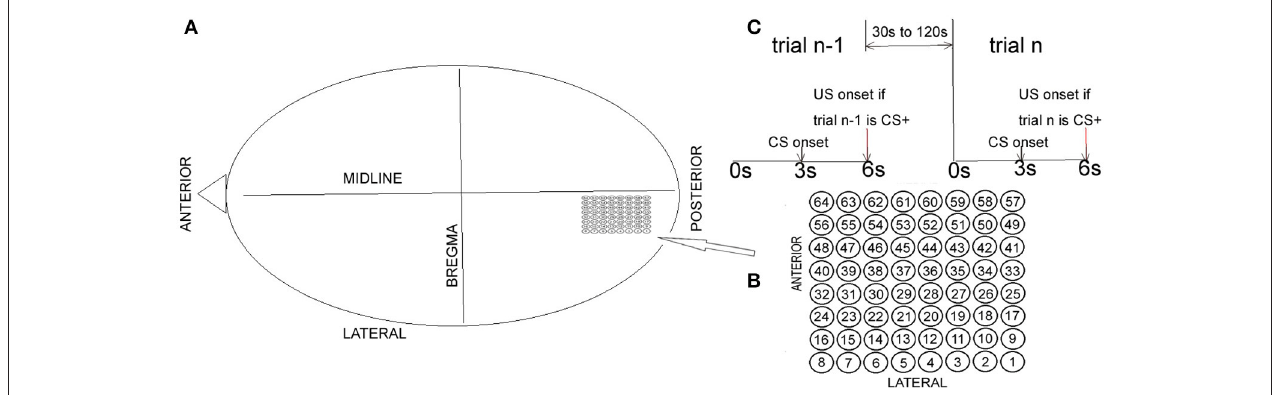
FIGURE 1 | Electrode array and basic summary of the experimental approach. (A) The electrode array was chronically implanted onto the epidural surface of the left visual cortex. (B) Electrodes and their corresponding numbers. (C) Basic summary of the experimental approach.